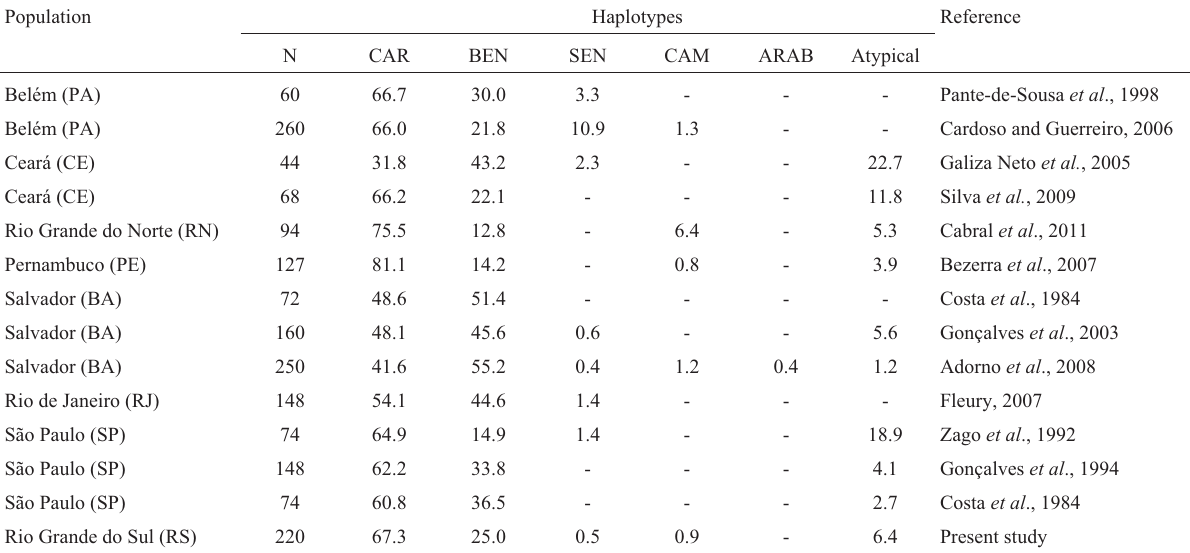
Table 1 - Frequency (%) of HBB*S haplotypes in Brazilian populations.